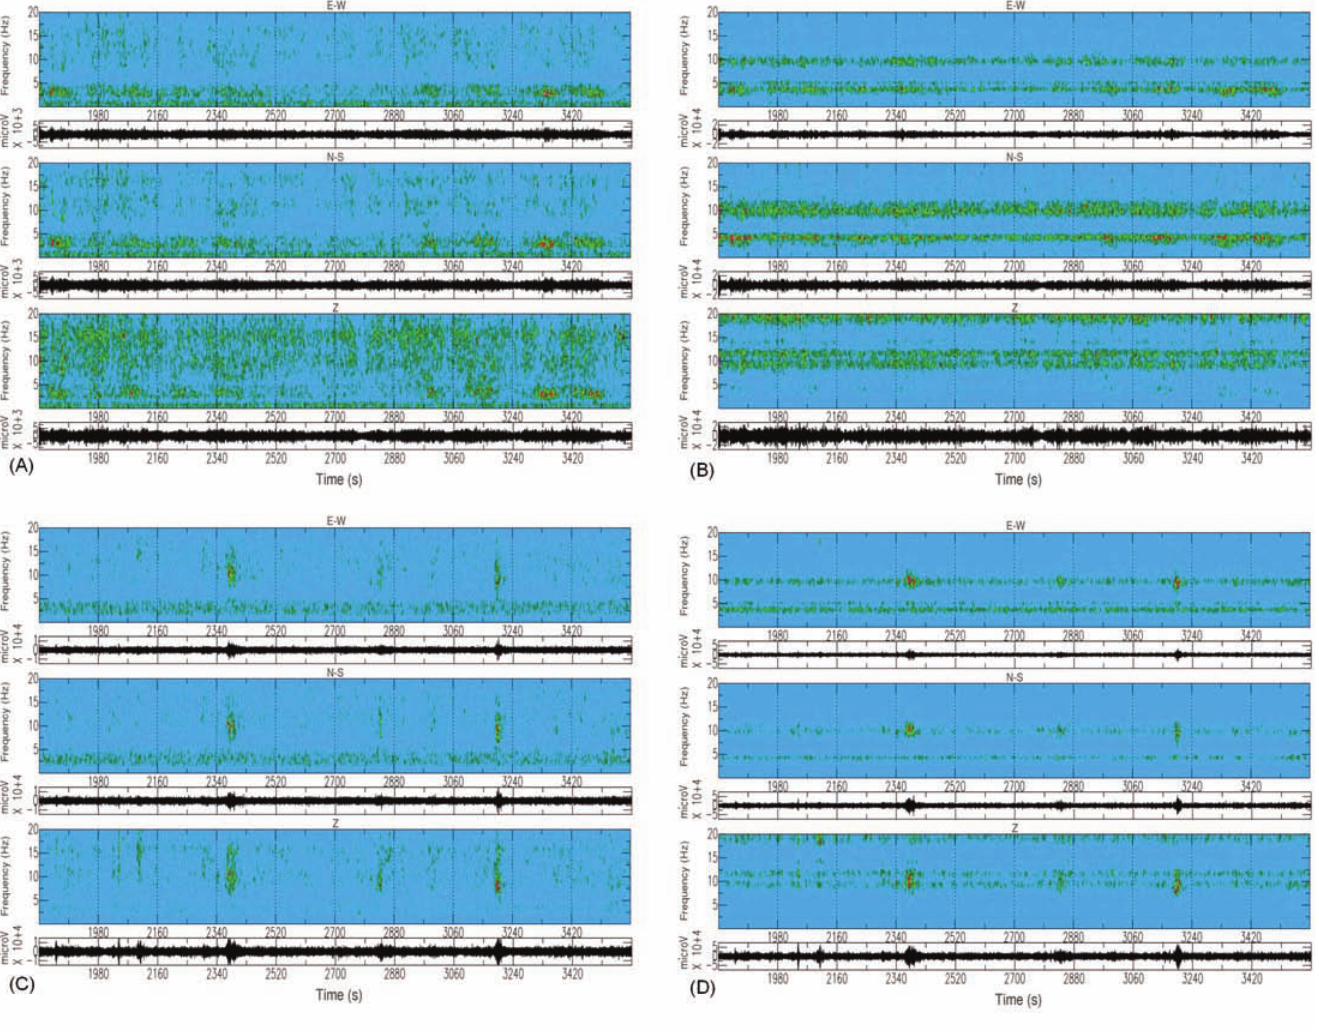
Figure 4. Spectrograms and noise seismograms. Spectral amplitudes (rainbow color scale) as a function of frequency (vertical axes) and time (horizontal axes) with their corresponding seismic signals immediately below each spectrogram, recorded for EW (upper strip), NS (central strip) and Z (bottom strip). (A, C) Station MVR0. (B, D) Station MVR2. (A, B) Recorded on February 7, 2010, between 00:30 and 01:00. (C, D) Recorded on February 7, 2010, between 12:30 and